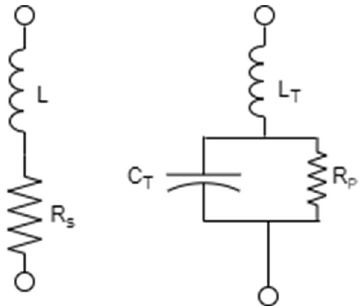
Figure 10. Circuit model of PIN diode in ON and OFF states.